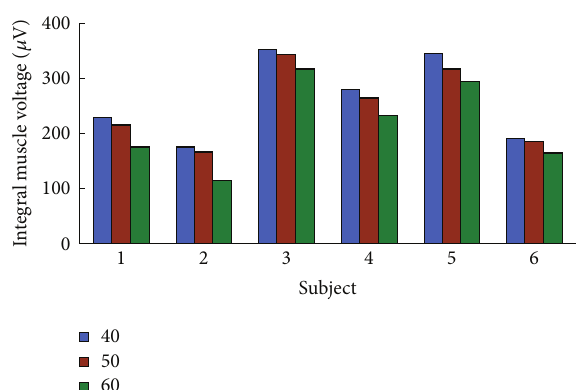
Figure 6: Subjects’ IEMG values for the major pectoralis using three different